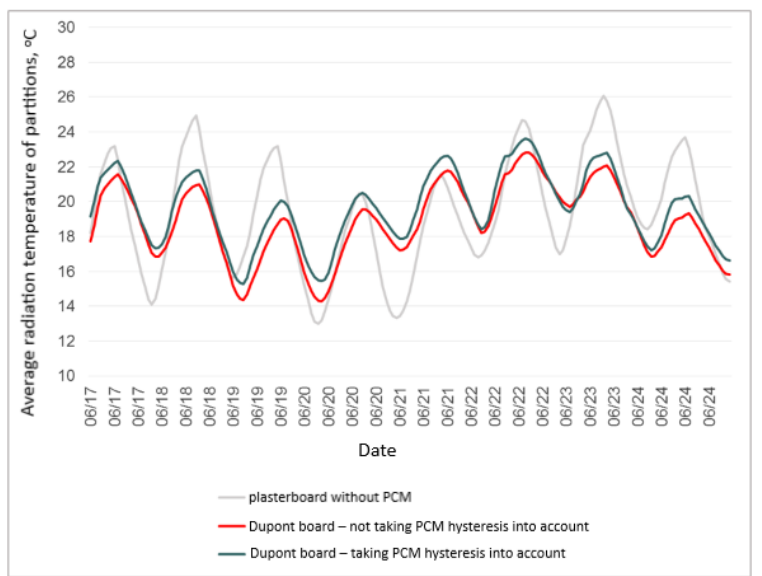
Figure 8. Average hourly values of radiation temperature of partitions inside a building with plasterboards in the period 5 June – 12 June.